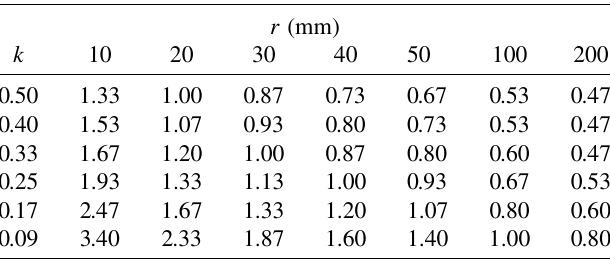
TABLE III. Ratio between sector width and aperture radius that gives 95% of the maximum critical gradient for a [0 (cid:9) –